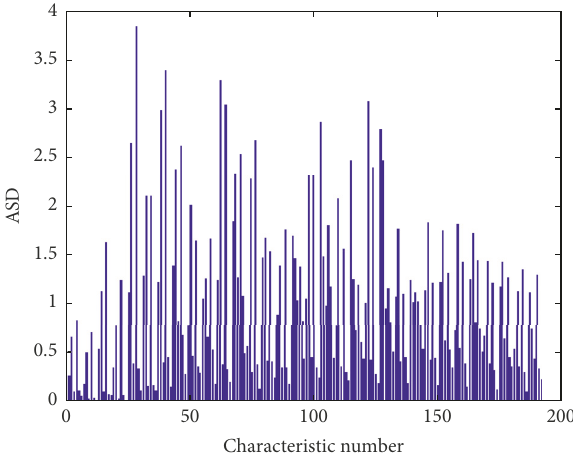
Figure 28: The ASD of 192 statistical characteristics of training samples.